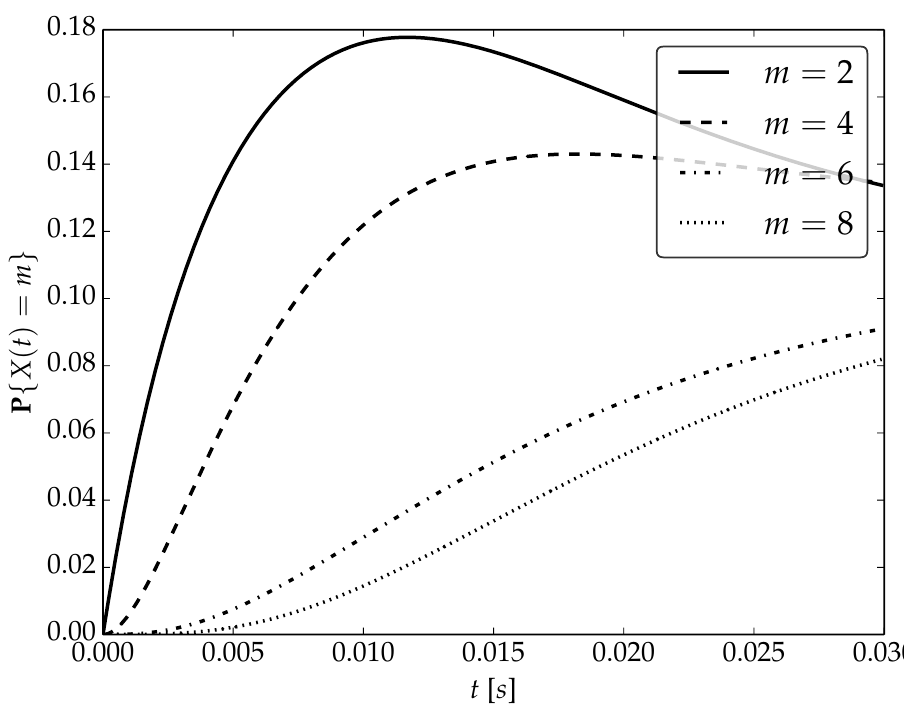
Figure 8. Transient distributions P { X ( t ) = m } for N = 4, batch distribution P 2 and ρ = 1.